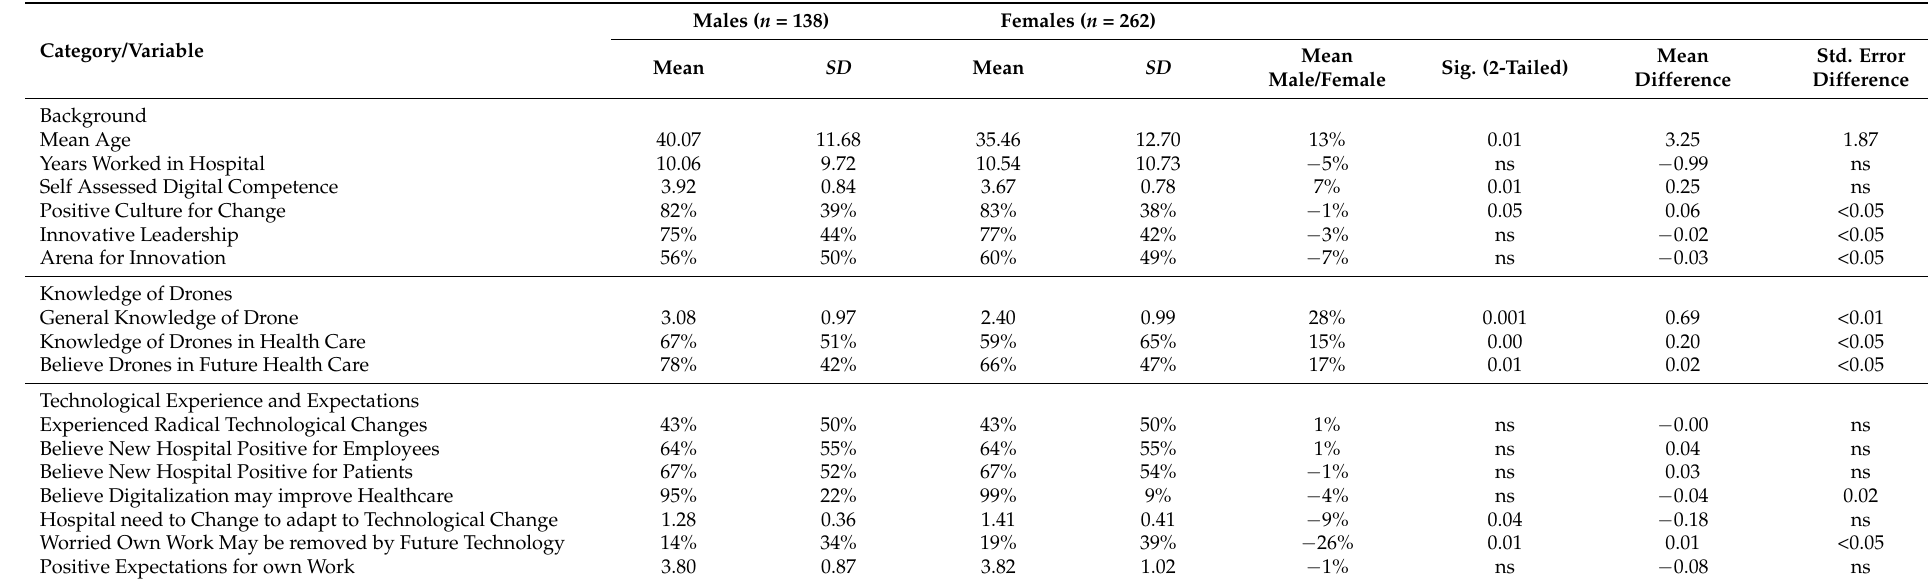
Table 2. Summary of data by